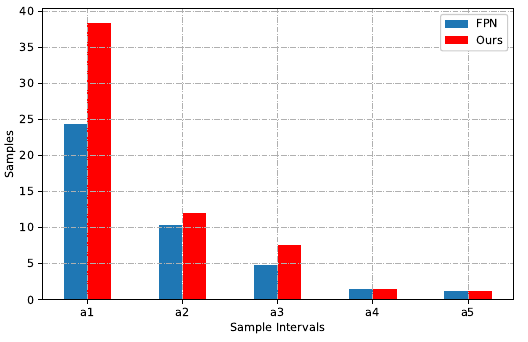
Figure 6. Distribution of multi-scale sampling and origin FPN sampling method.